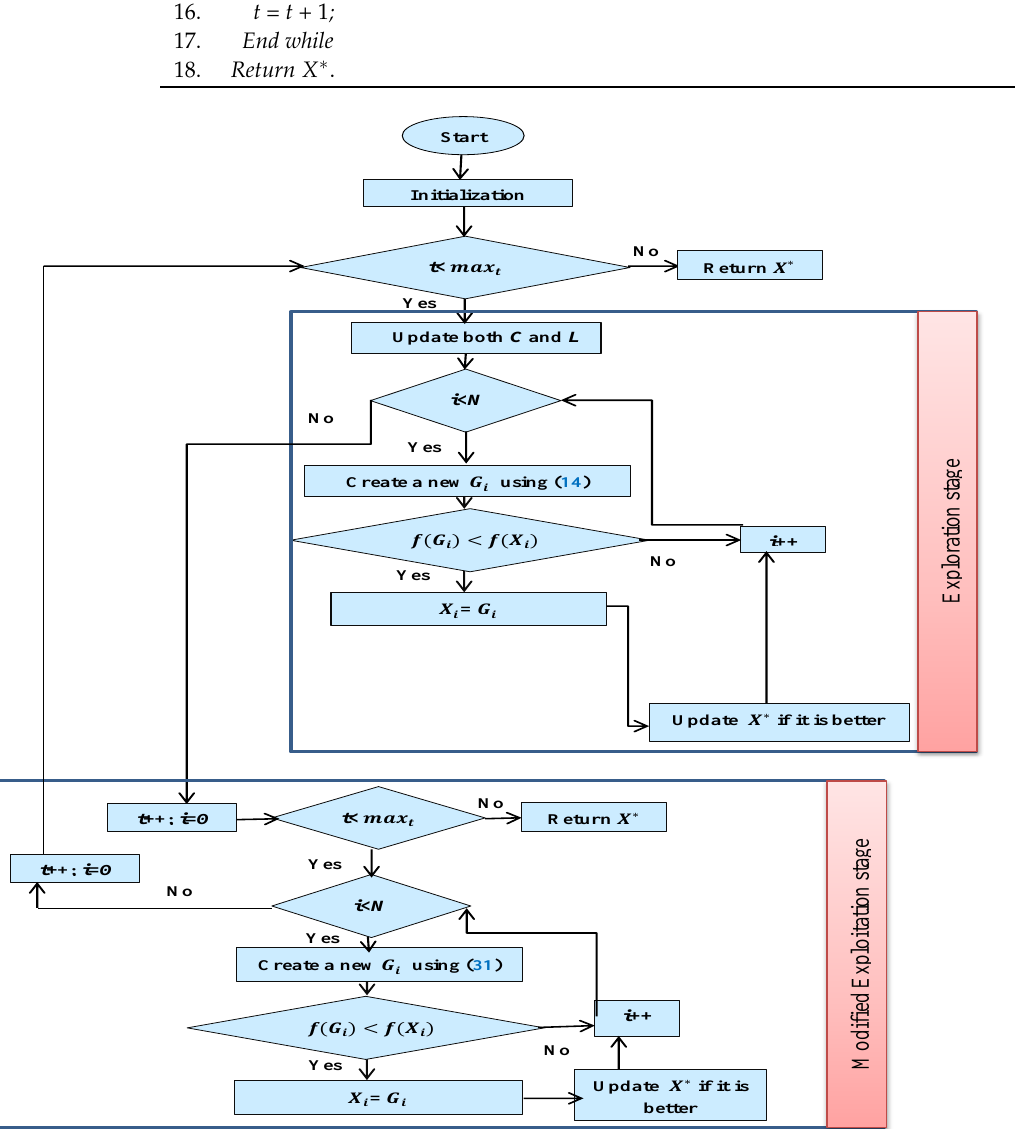
Figure 2. Flowchart of MGTO algorithm.